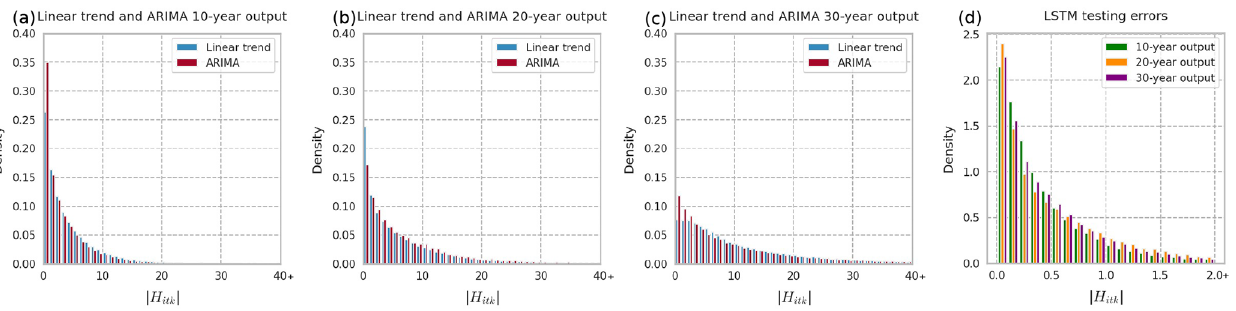
Figure 3. Absolute percent relative error ( | H | itk ) distributions for univariate models. (a) Linear trend vs. ARIMA 10-year output. (b) Linear trend vs. ARIMA 20-year output. (c) Linear trend vs. ARIMA 30-year output. (d) LSTM for all output lengths (note that the x -axis scale for d differs from the